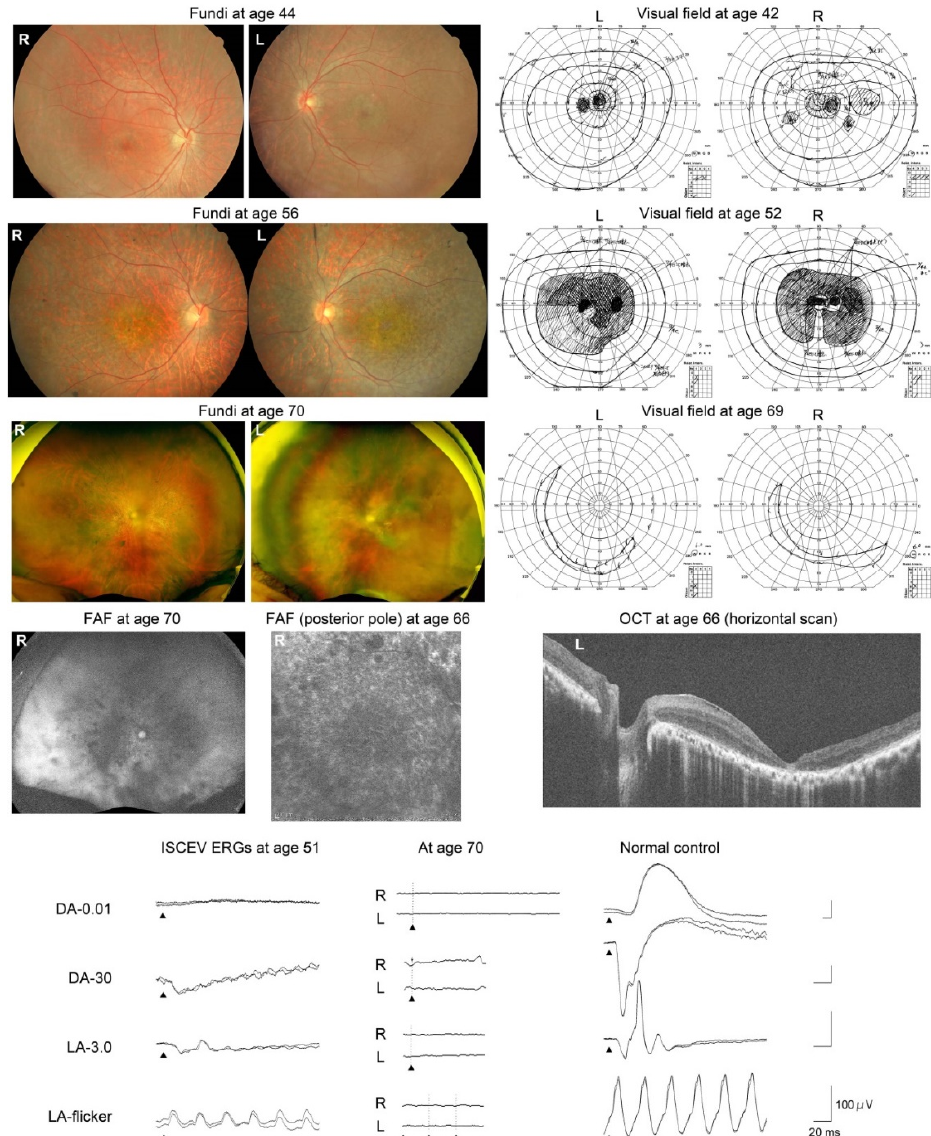
Figure 4. Results of fundus photography, FAF imaging, Goldmann kinetic visual field testing, OCT imaging, and ISCEV ERG in Patient 2 (Kinki-12-1022). This patient had a homozygous variant, c.221G > A, p.Arg74His, in the DRAM2